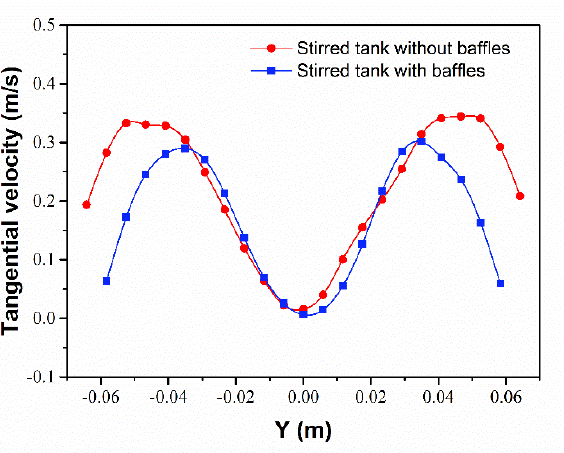
Figure 22. Comparison of the tangential velocity at H = 0.015 m on YZ plane of the stirred tanks with and without baffles.